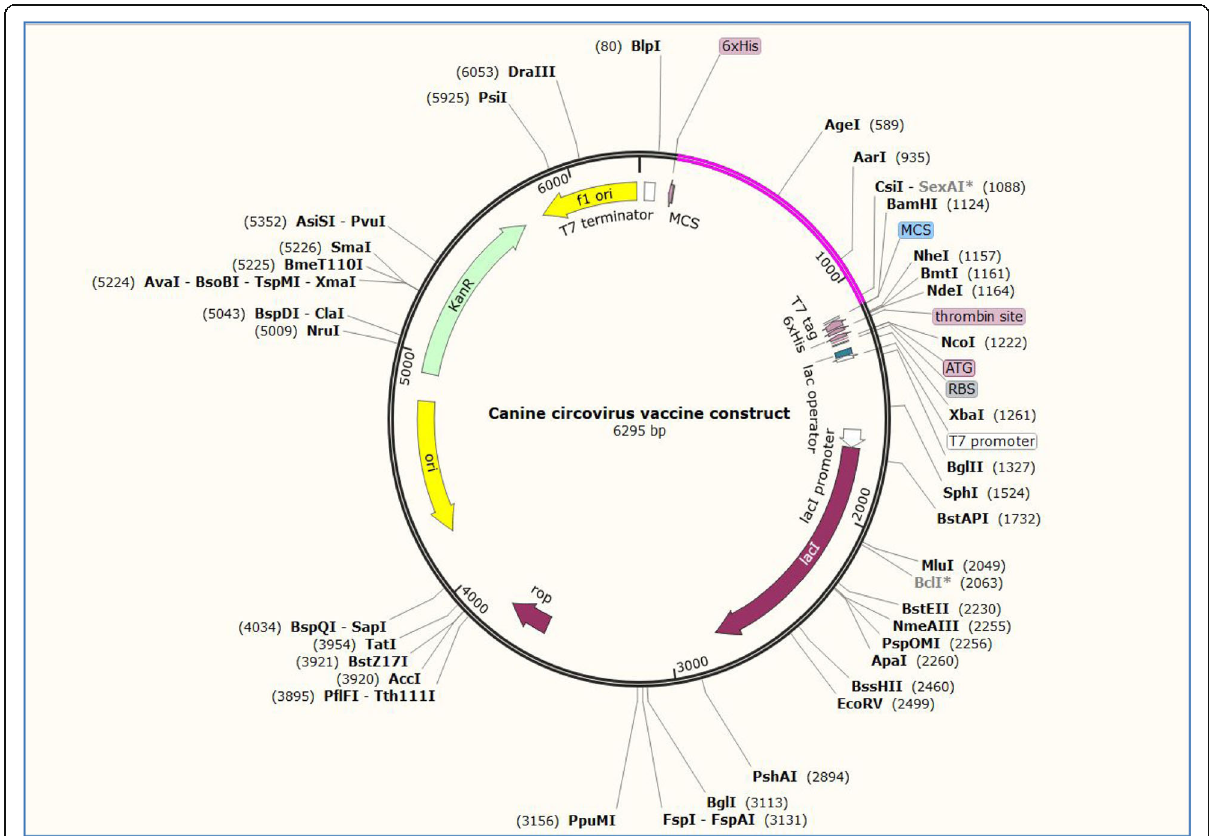
Fig. 7 Vaccine constructs in pET28a (+) vector: SnapGene restriction cloning module developed by Insightful Science was used for in silico cloning. During cloning, the codon-optimized vaccine sequence was inserted between XhoI (158) and EcoRI (192) restriction sites of the pET28a (+) vector (vaccine construct is shown in magenta